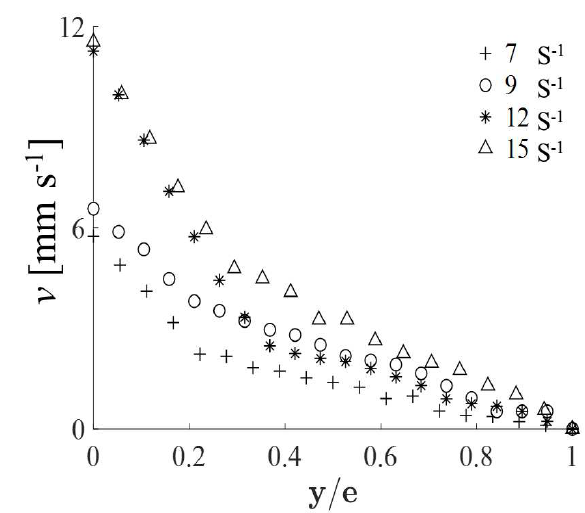
Figure 3: 1D velocity profiles across the normalized fluid gap y/e at steady state for different shear rates, showing shear banding, where e refers to the fluid gap width of 1